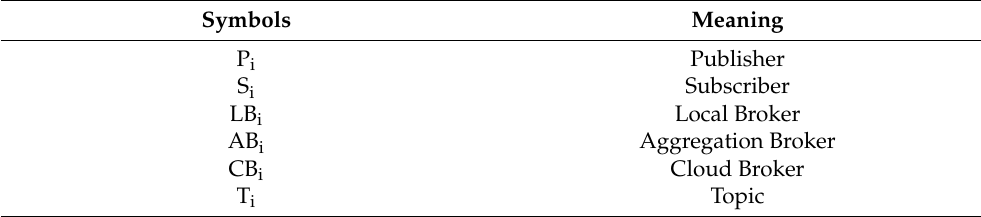
Figure 2. Multi-tier MQTT broker based on fog computing (Mu-TiMB). Table 2. Notation used in Mu-TiMB architecture.